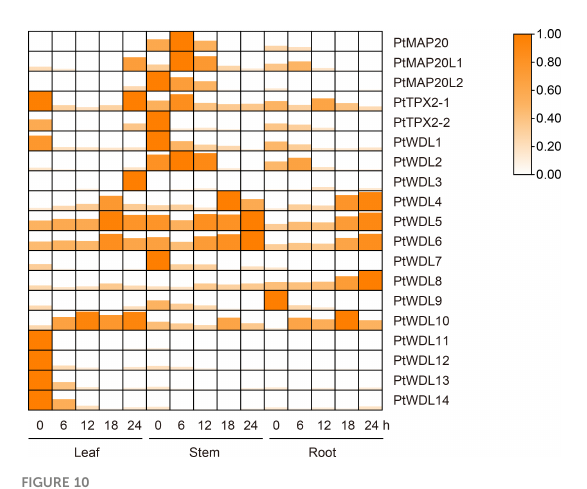
FIGURE 9 Heatmap of PtTPX2 gene expression patterns in different tissues and processing time under heat stress. The graphic size and color represent the level of expression of each gene in each sample. The gene expression levels were calculated based on 2 − DD Ct .